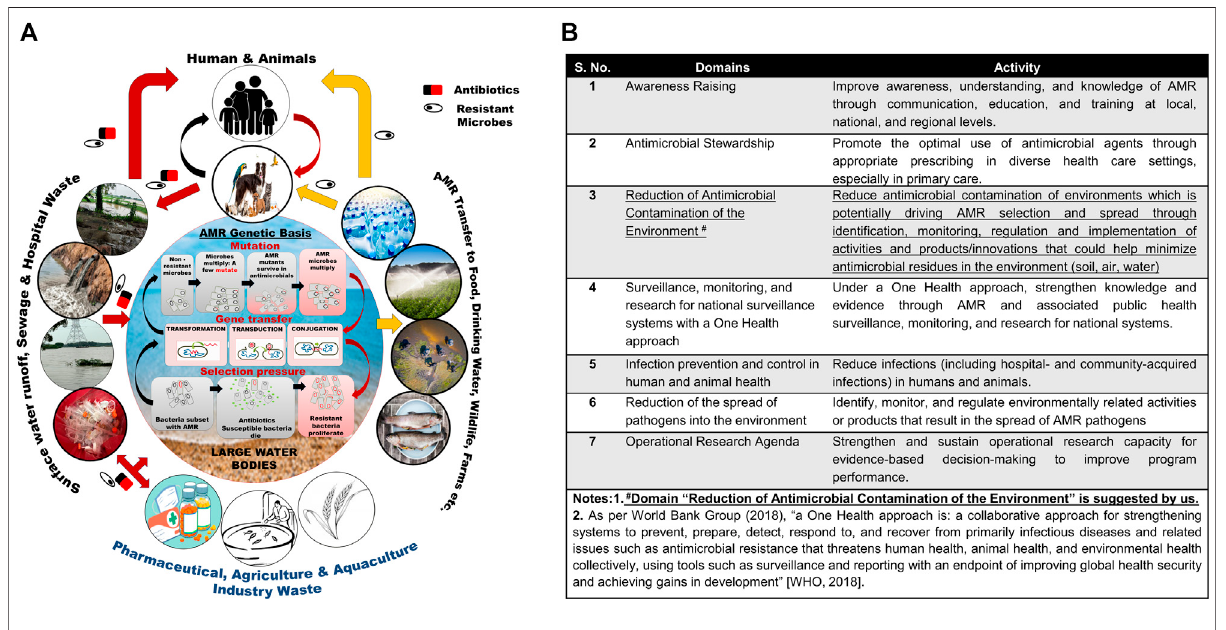
FIGURE 1 | (A) Antimicrobial resistance development and transmission of ARGs and ARBs. (B) One health approach to AMR crises: Seven domains and activity for guiding the data collection, analyses, and action.